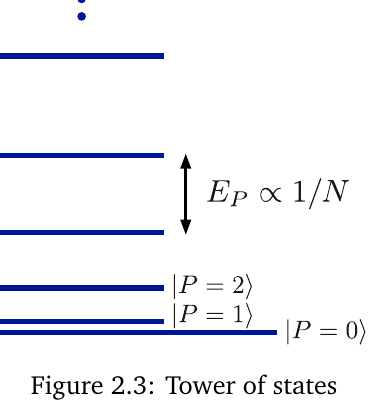
Figure 2.3: Tower of